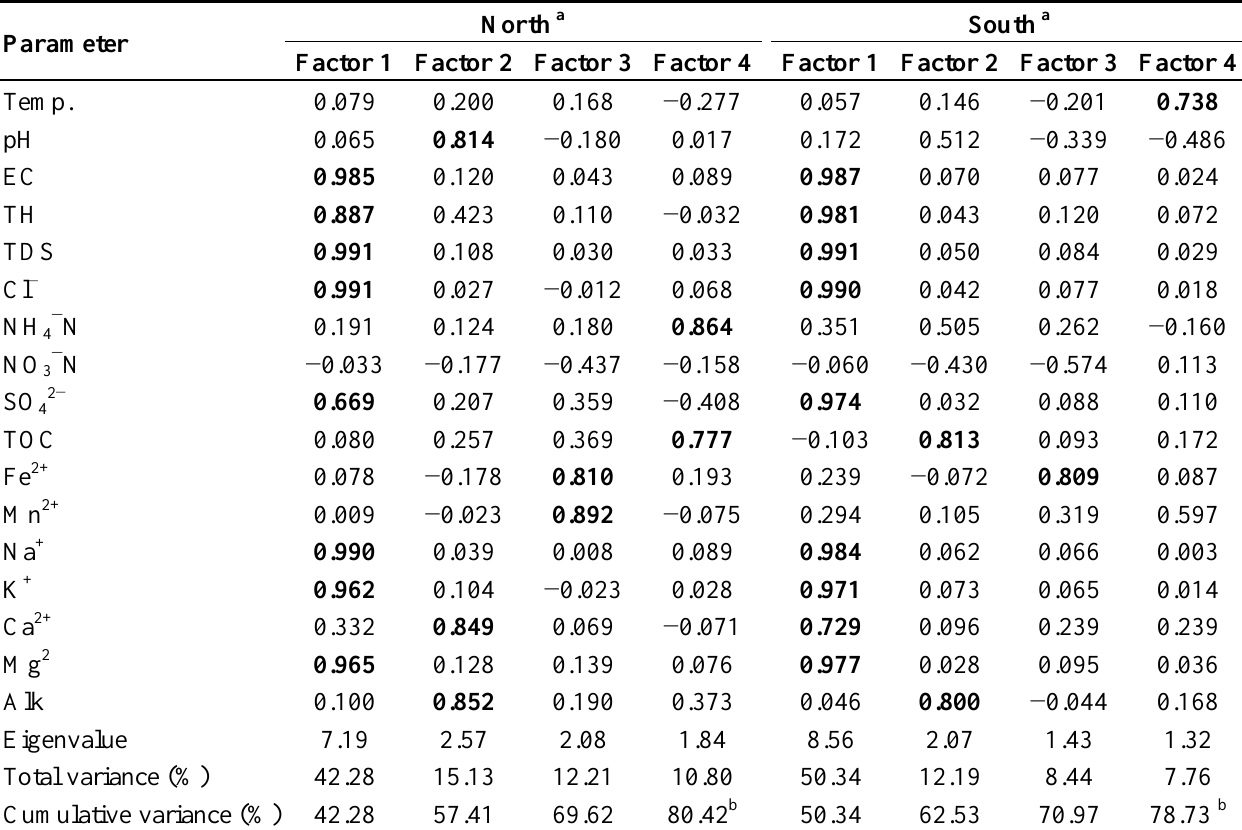
Table 3. The rotated common factors for loadings, the percentage of variance and the total cumulative percentage of variance in the southern and northern